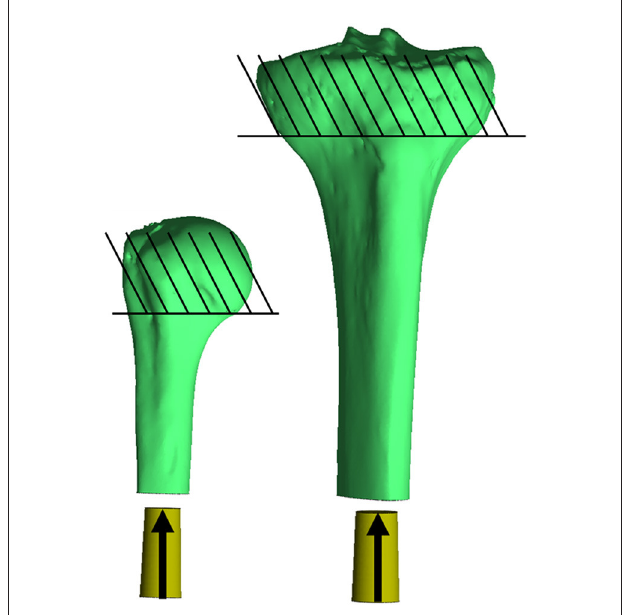
FIGURE 2 | Impaction of the endoprosthesis along the long axis of the bone through the centroid of the medullary canal, parallel to the inertial axis of the medullary canal. The endoprosthesis was placed at the distal end 5mm proud the distal osteotomy, so no contact occurred with the bone (30mm to the bone from where it is currently pictured). Contact began with the endoprosthesis 3mm proud the distal osteotomy, and subsequent impaction created a maximum of ∼ -0.1mm mismatch in diameter of the prepared bone endosteal surface to the endoprosthesis. Bones were fixed proximal to the humeral head and tibial tuberosity. *Relative sizes of the bones are approximately to